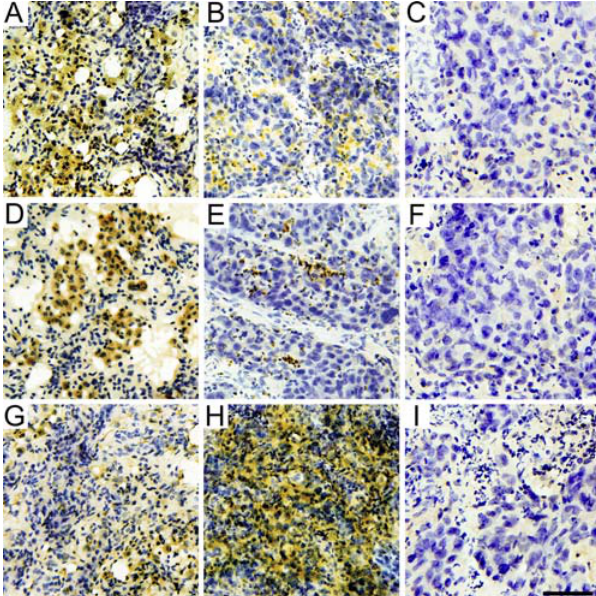
Figure 3. Representative immunohistochemistry result, staining for Cyr61, CTGF, and WISP-1 in NSCLC and matched normal lung tissues. In non-cancerous lung tissues from patients with NSCLC, intense Cyr61 immunoreactivity (brown) is observed in the cytoplasm of cells as well as extracellular space (A). In corresponding NSCLC tissues, Cyr61 immunoreactivity is less (B) compared with normal lung tissue. Similar to Cyr61, many CTGF-positive cells (brown) are visible in non-tumor lung tissues (D), and positive signals are only sparsely distributed in NSCLC tissues (E). WISP-1 immunohistochemistry, however, displays a different expression pattern. WISP-1 immunoreactivity (brown) is barely detected in normal lung tissues from NSCLC patients (G) but is markedly increased in NSCLC tissues (H). C, F, and I are negative controls of Cyr61, CTGF, and WISP-1, respectively. All slides are counterstained with hematoxylin (blue). Scale bar=60 m